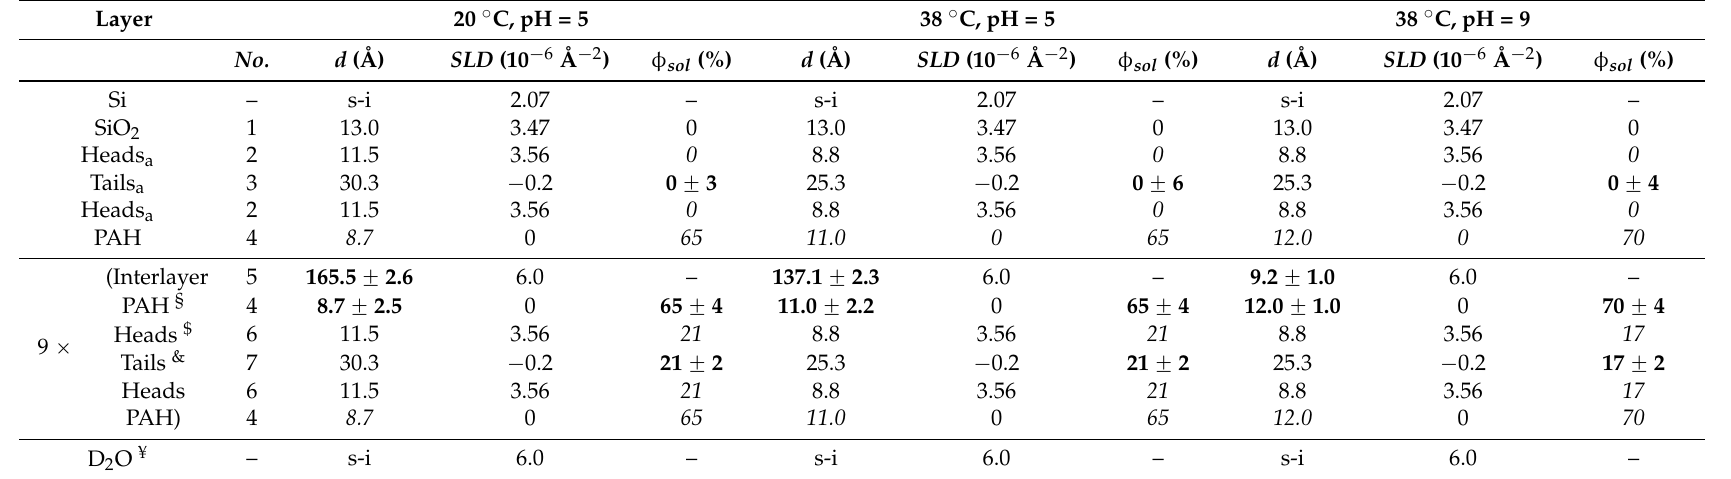
Table 2. Structural parameters of sample B incubated with PAH-15 in D 2 O (3